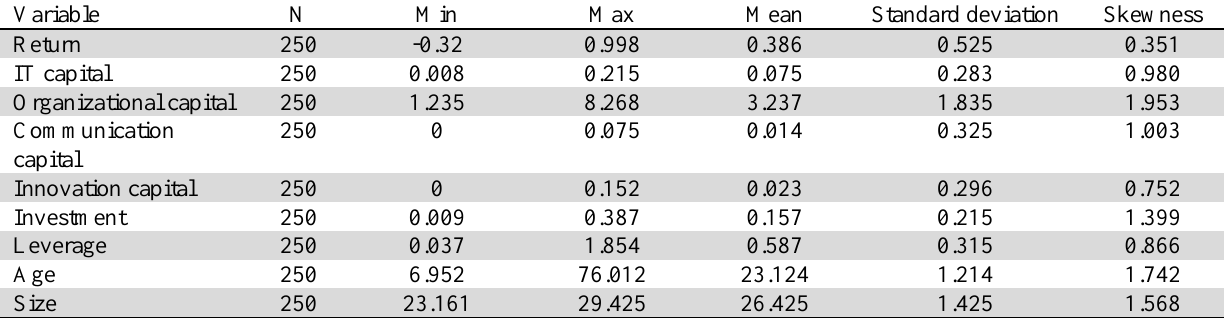
Summary of some basic